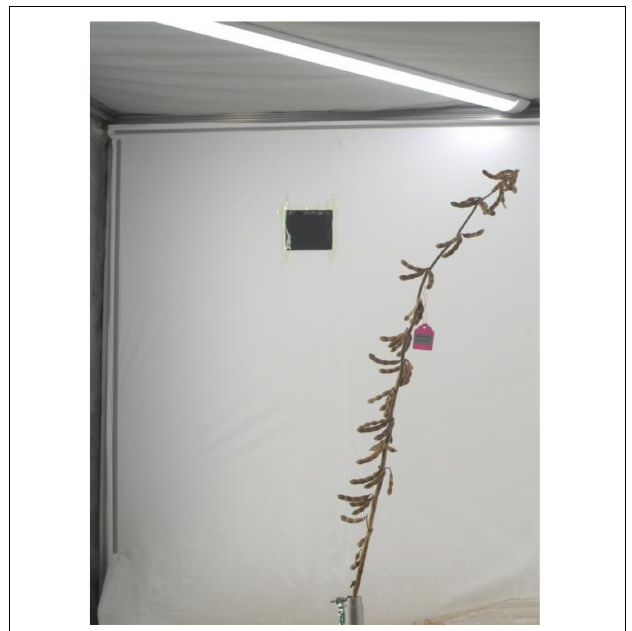
FIGURE 4 | Single plant